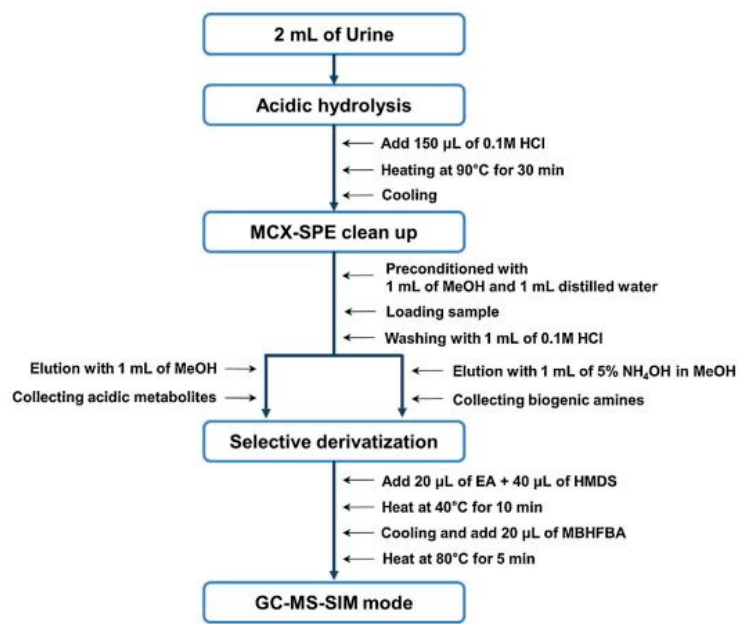
Figure 4. Overall analytical procedure for the analysis of biogenic amines and their acidic metabolites in urine by GC/MS in selective ion monitoring (SIM) mode. Figure adopted from reference [66] with the copyright